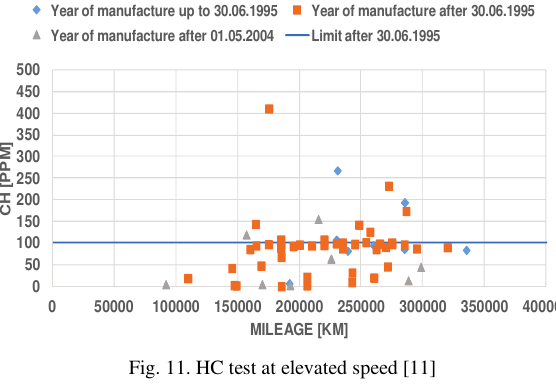
Fig. 8. CO test at idle [11]